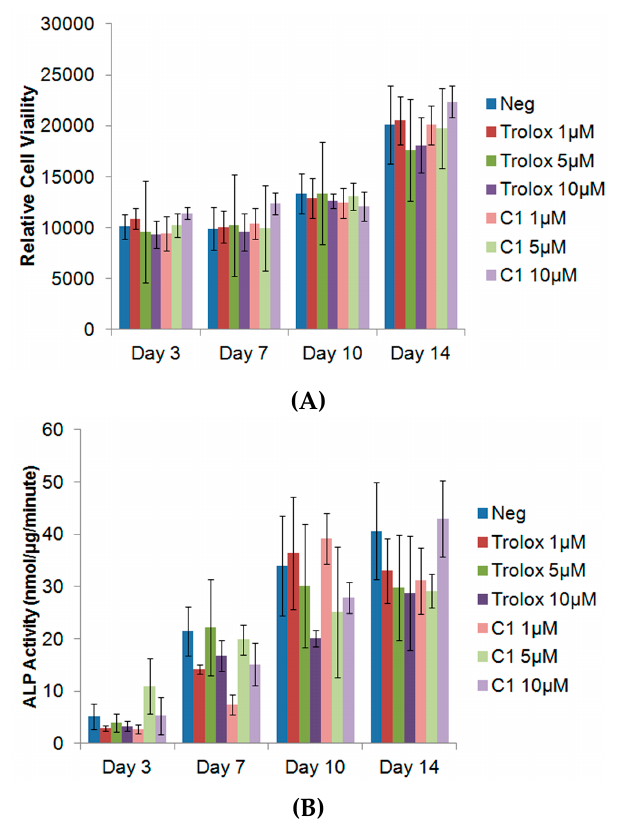
Figure 5. Cell Viability of MC3T3-E1 after exposure to antioxidants C1 and Trolox ( A ) and ALP activity after exposure to antioxidants C1 and Trolox ( B ). Data expressed as mean ± standard deviation.